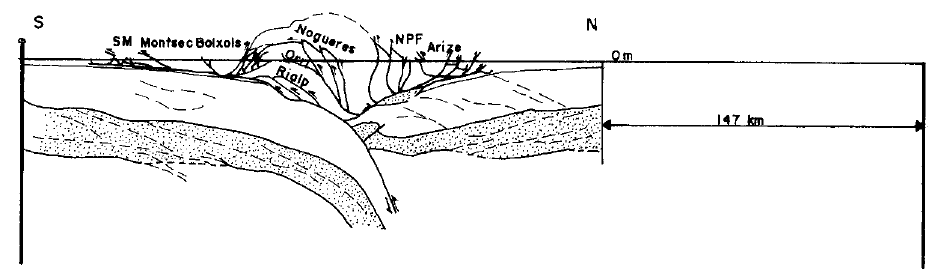
Fig. 3 – A basement-involved antiformal stack in a balanced cross-section of the middle of the Pyrenean continental collision belt, after 39% shortening (Muñoz,